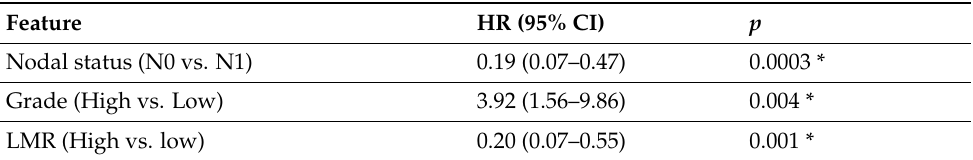
Table 3. Multivariable model predicting death in the current cohort. *—statistically significant. Abbreviations: LMR—lymphocyte to monocyte